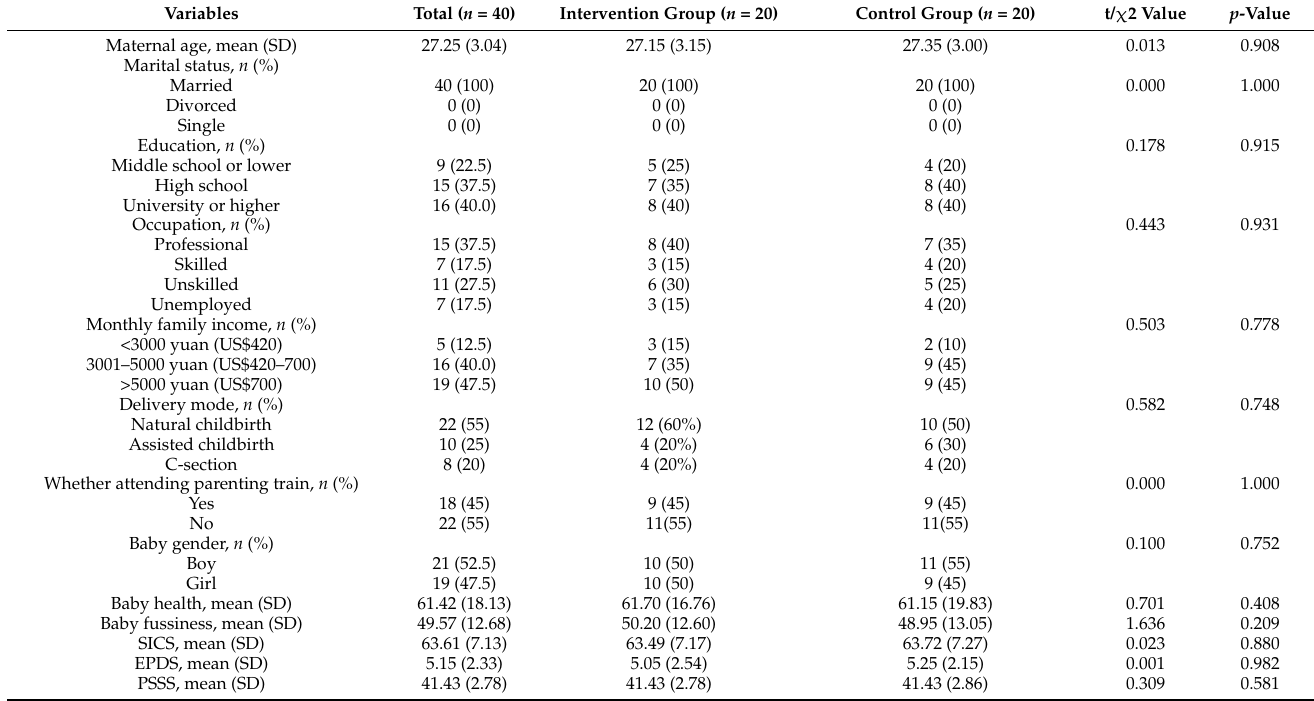
difference = 4.302, p = 0.001); and no significant difference at T2 (mean difference = 0.350, p = 0.743) (Table 3). Table 2. Comparison of socio-demographic characteristics and baseline outcomes between the groups. Variables Total ( n = 40) Intervention Group ( n = 20) Control Group ( n = 20) Maternal age, mean (SD)